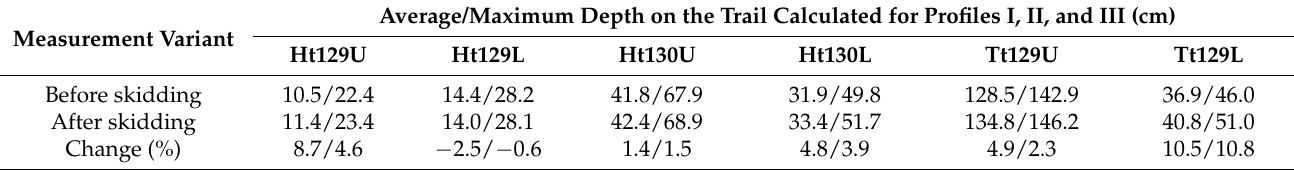
Table 6. Average and maximum depth in the central 1.5-m-wide section of the trail before (T1) and after timber skidding (T2). Measurement Variant